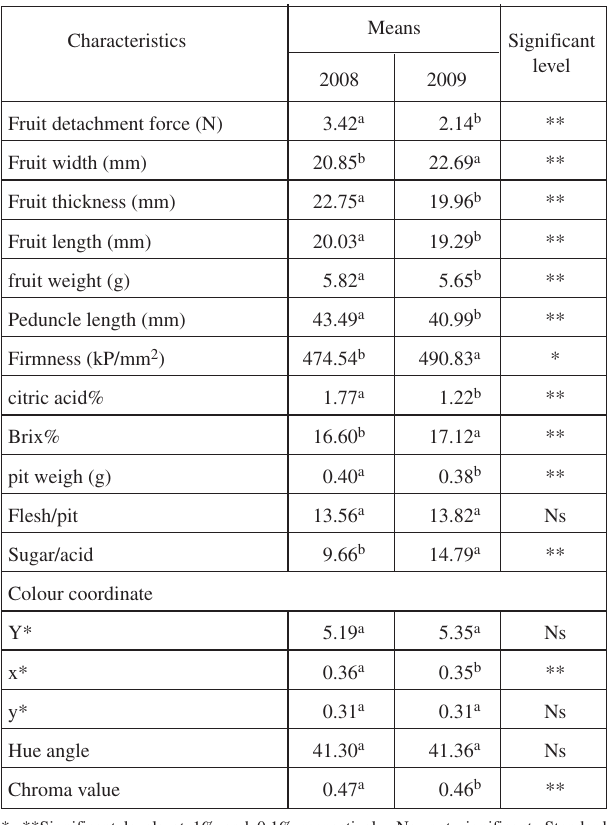
Table1. Mean values of assessed characteristics and their span in 2008 and 2009 Means SignificantCharacteristics